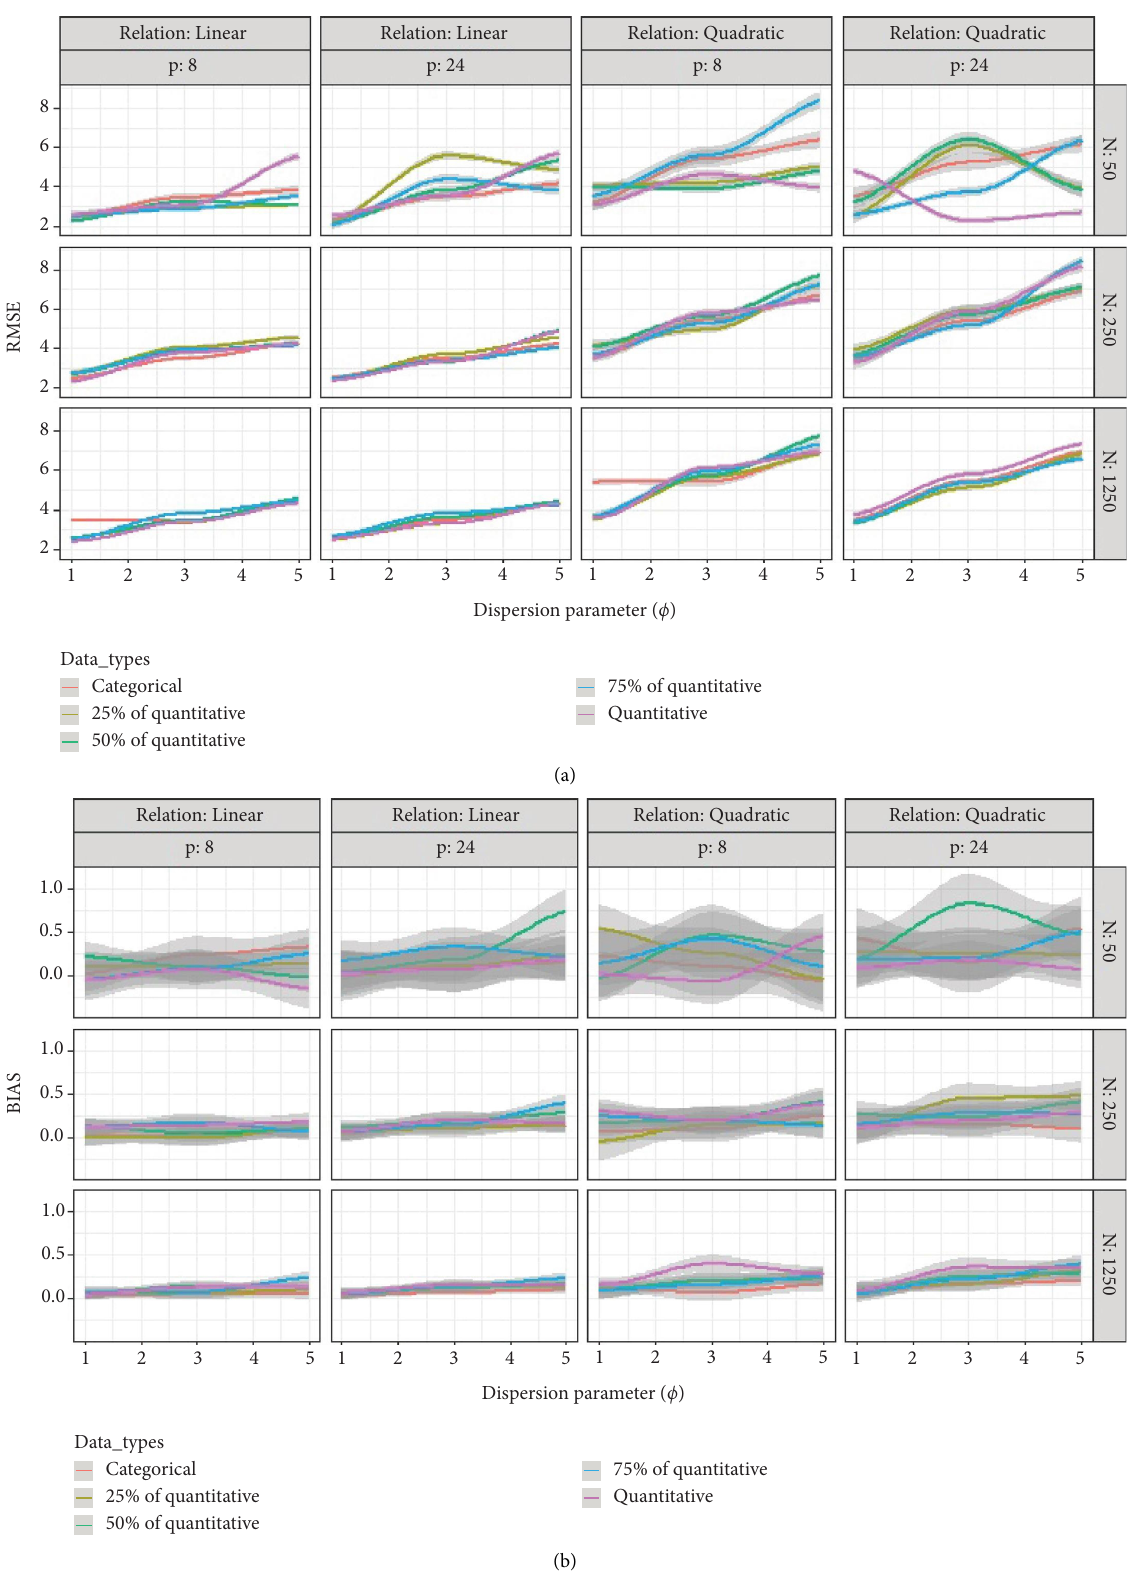
Figure 5: Impact of the response variable overdispersion on RF accuracy (relation is the outcome’s variance-to-mean relationship). (a) RMSE and (b)